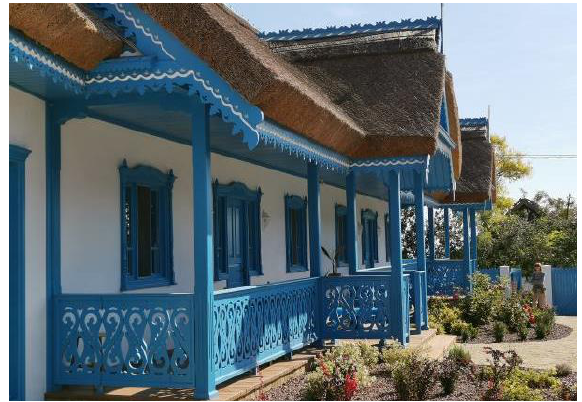
Figure 12. Extension of an old house, Sarichioi